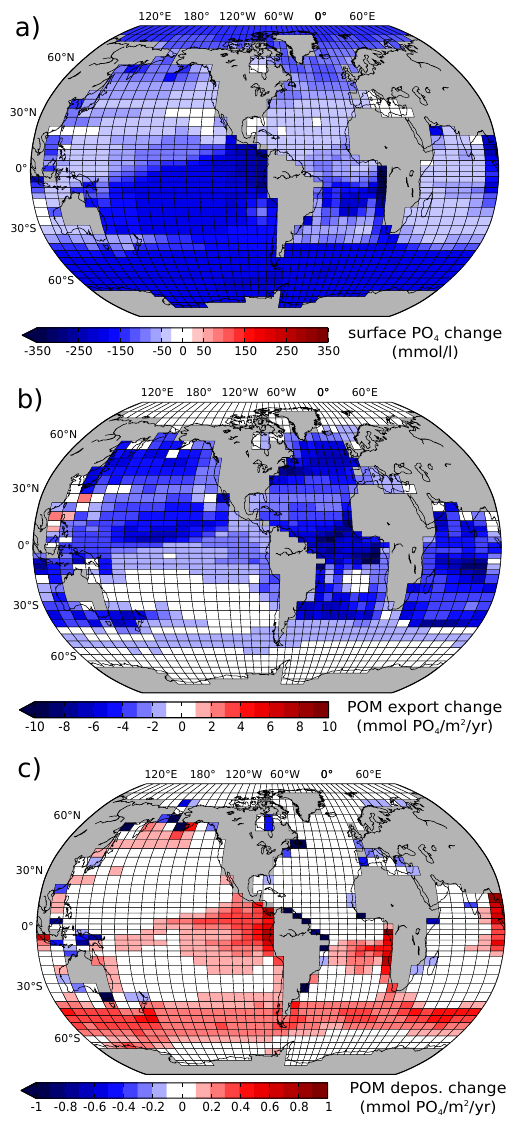
Figure 4. Equilibrium changes in annual mean ocean proper- ties in a POM remineralisation deepening experiment ( l POM : 250m → 275m). (a) Change in surface (top 80m) seawater PO 4 concentration, (b) change in POM export flux and (c) change in seafloor POM deposition